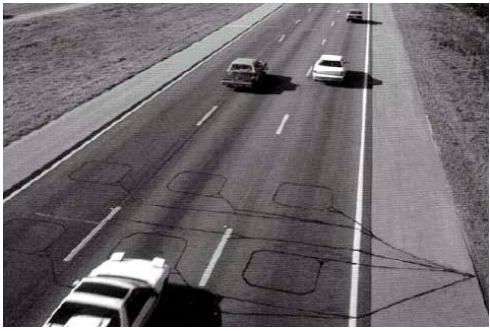
Figure 5. Induction loop detectors at freeway location on the roadway [16].